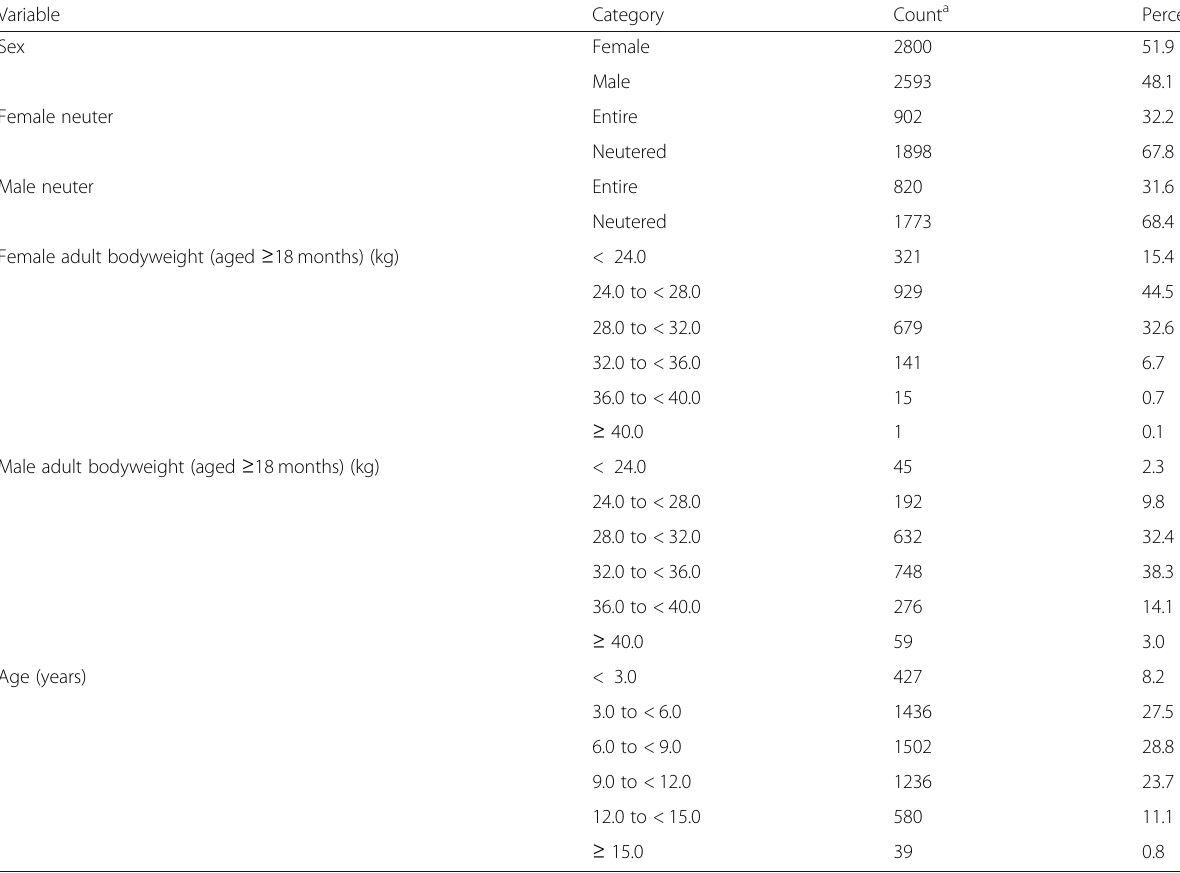
Table 1 Demography of 5419 greyhounds under primary veterinary care at practices participating in the VetCompass ™ Programme in the UK from January 1st to December 31st,